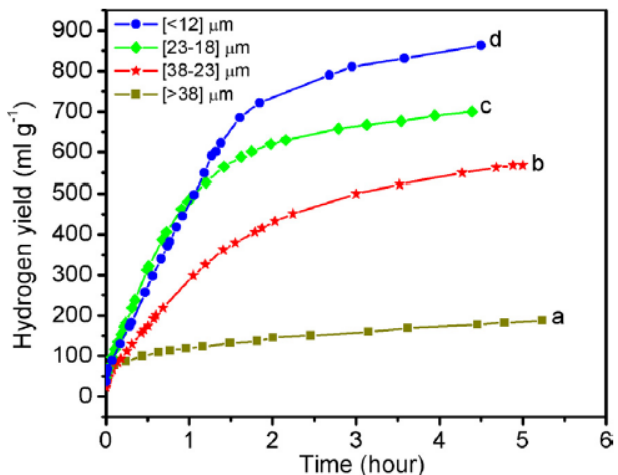
Figure 6. The hydrogen evolution curves of H-Mg 3 La with different particle sizes [68].